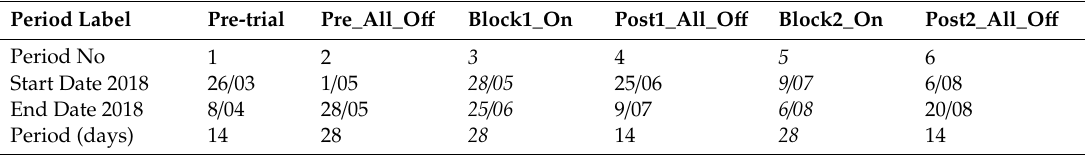
Table 1. Periods with On-O ff Periods 3 and 5 disaggregated to On and O ff Blocks excluding bu ff er sections 1 and 8 (Block 1: Sections 2, 4 and 6; Block 2: Sections 3, 5 and 7). The periods when the virtual fence (VF) was switched on are